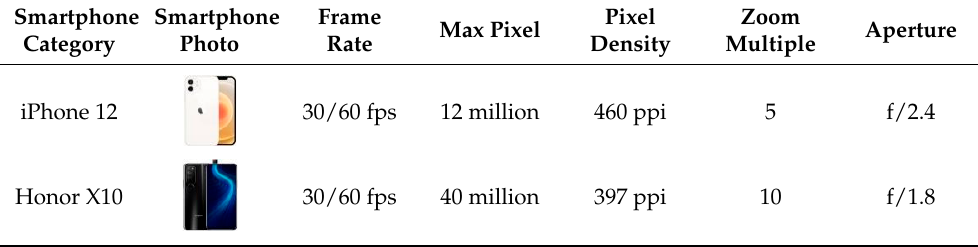
Table 1. Parameters of two smartphone cameras.